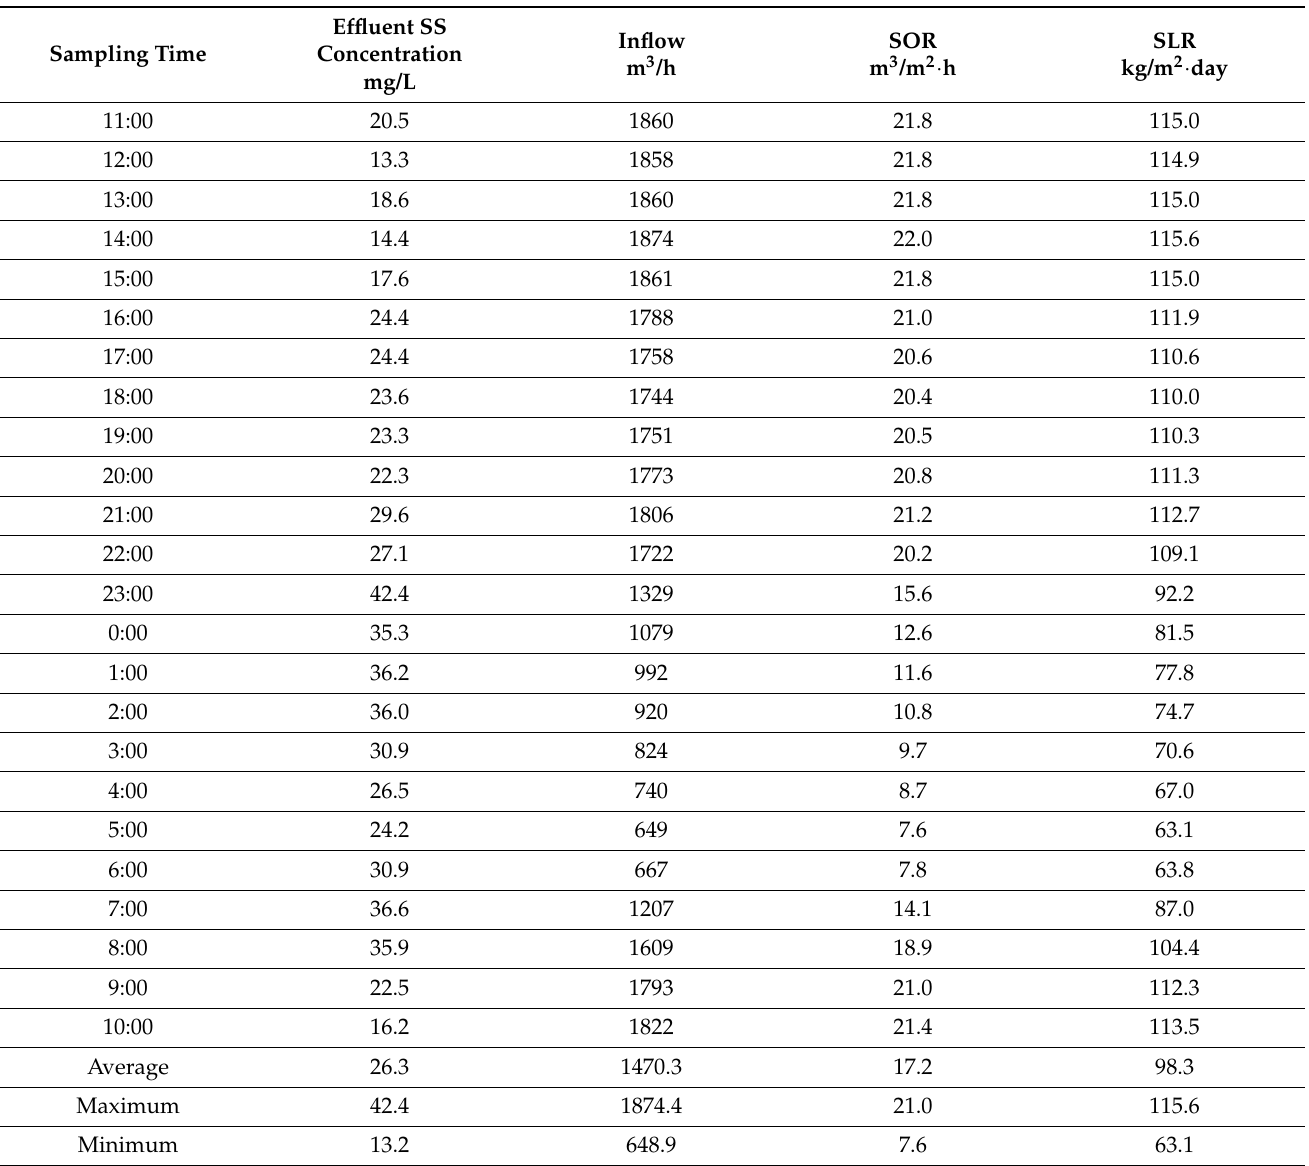
Table 4. Average hourly secondary effluent SS concentrations and corresponding average hourly inflows, SORs, and SLRs at the secondary clarifier at plant